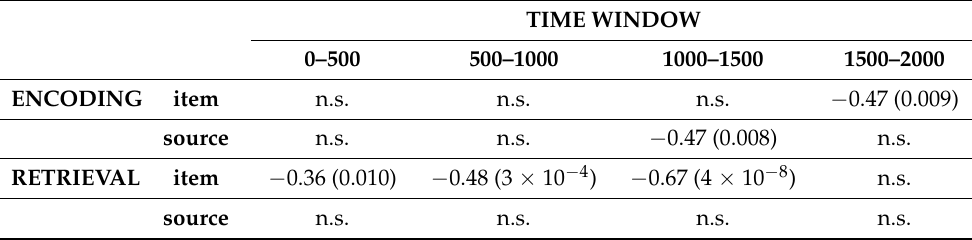
Table 3. Overview of Pearson’s correlations between beat stimulation-related (BB-MB) firing rate differences in the pre-stimulus window [ − 500; 0 ms] and memory-related (REM-FORG) firing rate differences in the post-stimulus